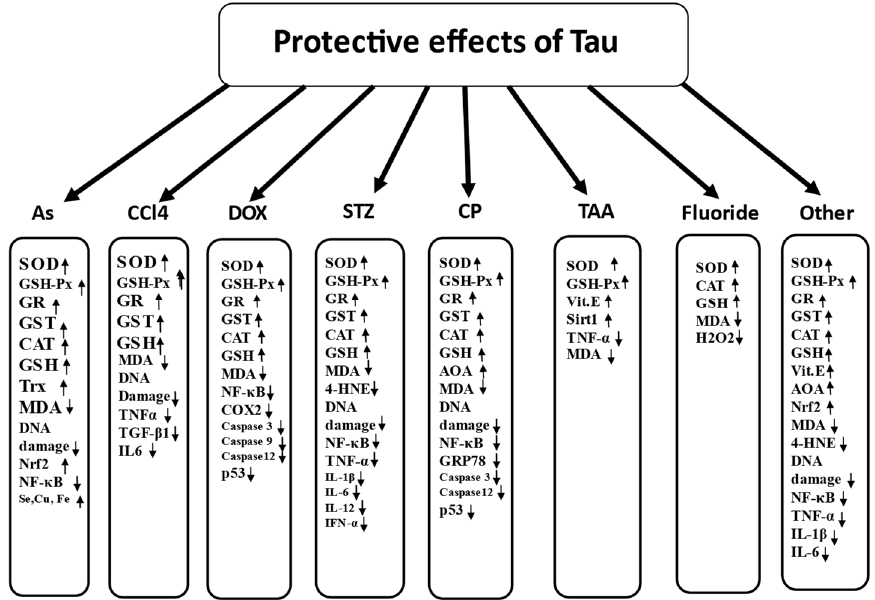
Figure 1. Protective antioxidant effects of Tau. For abbreviations, refer to the index (adapted from